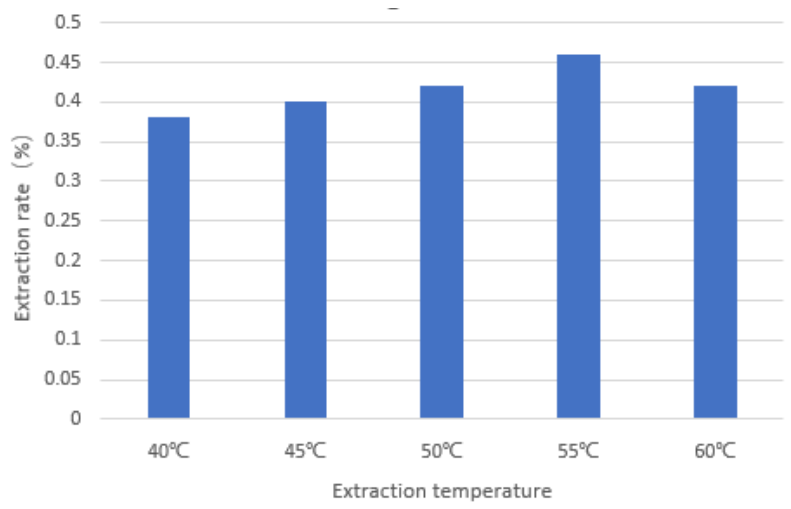
Figure 3. Effect of the extraction temperature on the extraction rate.